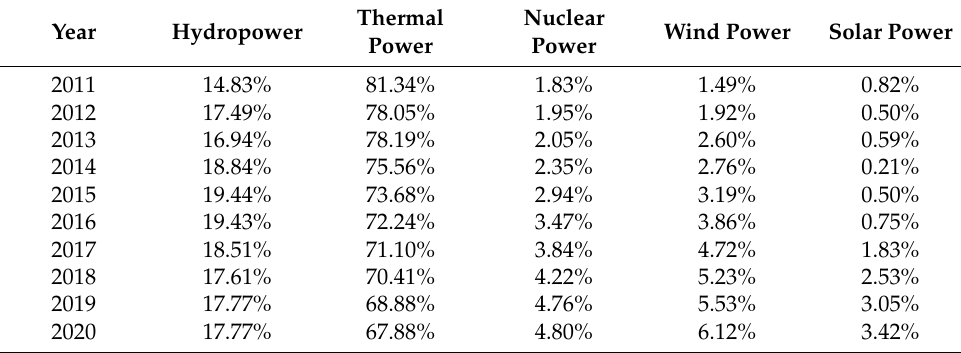
Table 1. Power production structure in China from 2011 to